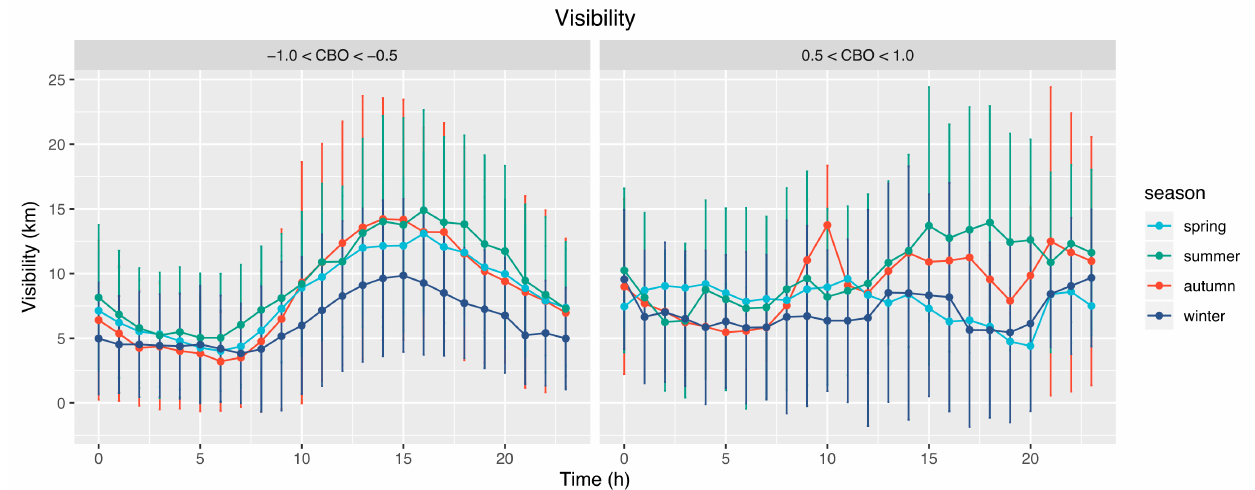
Figure 14. Diurnal variations of visibility in two situations: ( left ): − 1.0 < CBO < − 0.5 and ( right ): 0.5 < CBO <